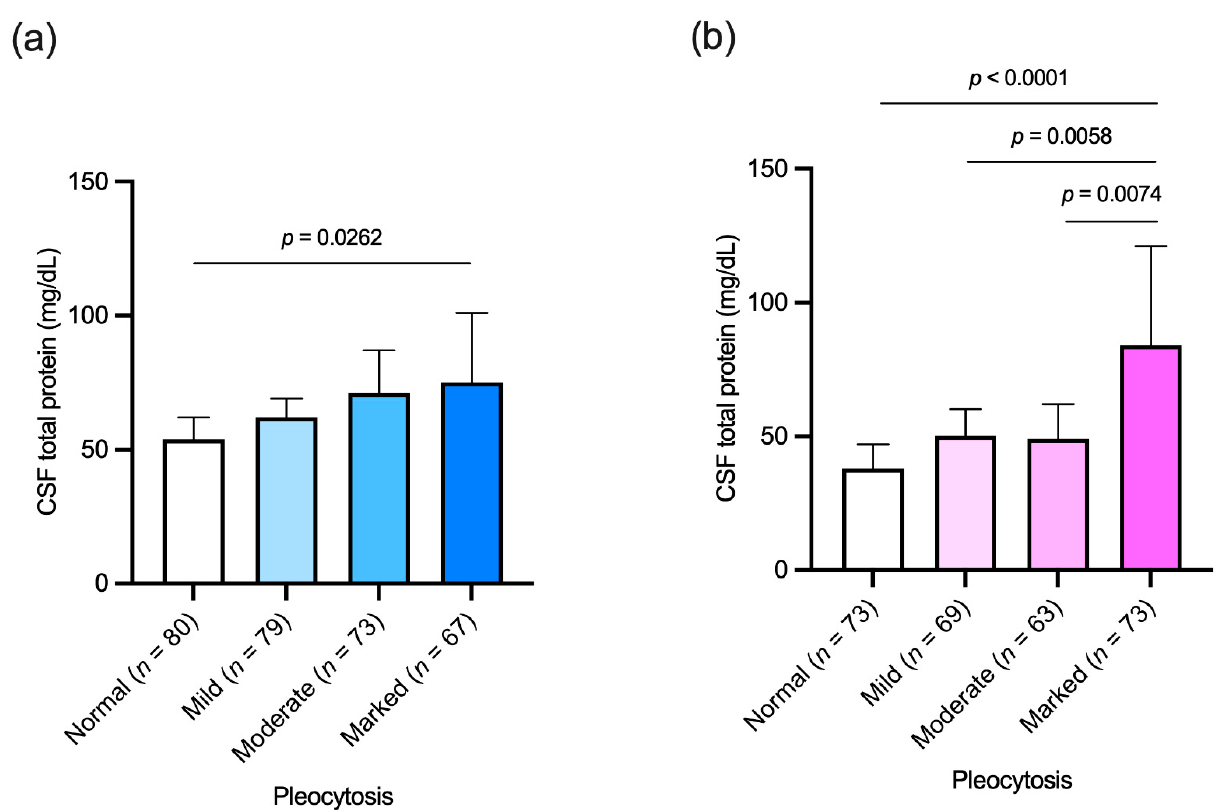
Figure 3. Cerebrospinal fluid (CSF) total protein levels in patients grouped by pleocytosis severity; normal (no more than 5 cells/ µ L); mild (6–25 cells/ µ L); moderate (26–100 cells/ µ L); marked (more than 100 cells/ µ L). ( a ) Men; ( b ) women. Kruskall–Wallis with Dunn’s multiple comparisons test were used in both analyses. Bars represent medians and 95% confidence intervals.